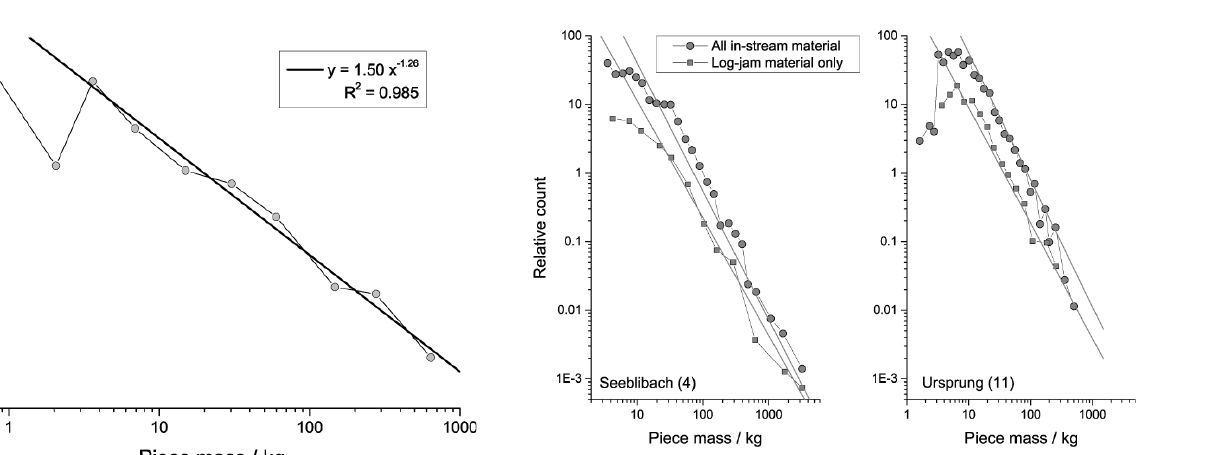
Figure 6. Scaling distributions of piece mass for LWD locked in log jams in the Erlenbach channel. 5 Discussion